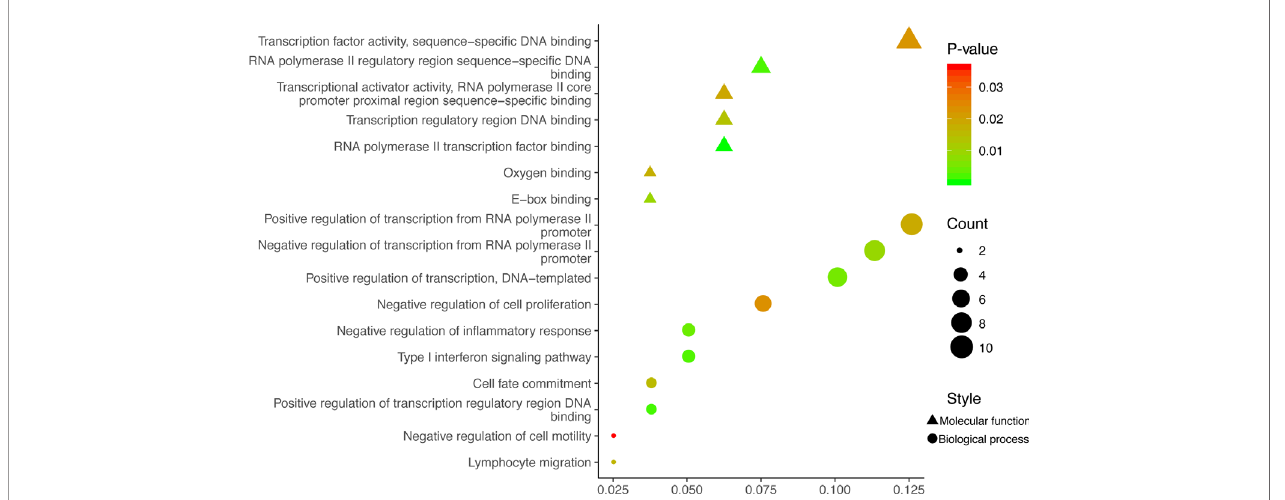
FIGURE 4 | MeDEG gene ontology enrichment analysis. Molecular function and biological process terms for MeDEGs are shown as “ triangles ” and “ circles ” , respectively. “ Count ” represents the number of genes. MeDEGs, methylation-regulated differentially expressed genes.